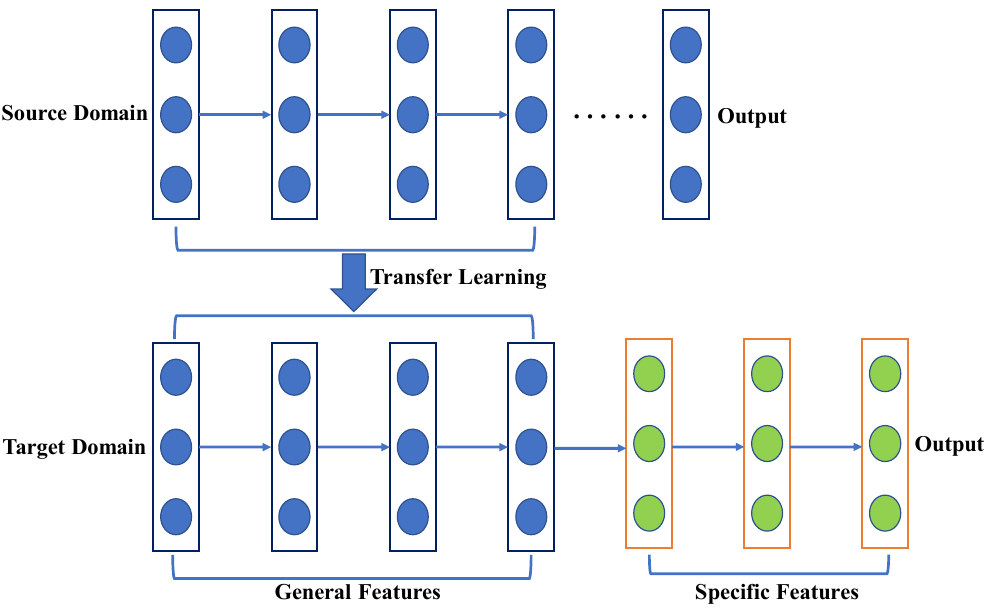
Figure 1. Schematic diagram of the transfer learning used in this paper.